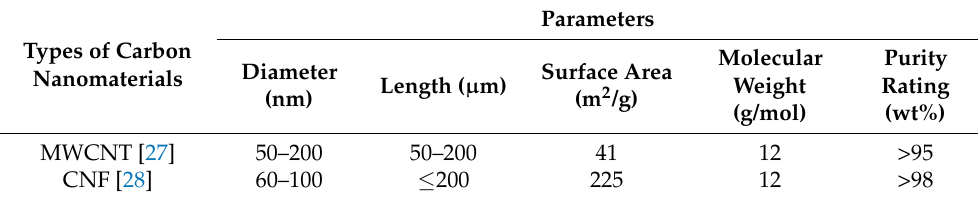
Table 1. Specification of carbon nanomaterials in this study